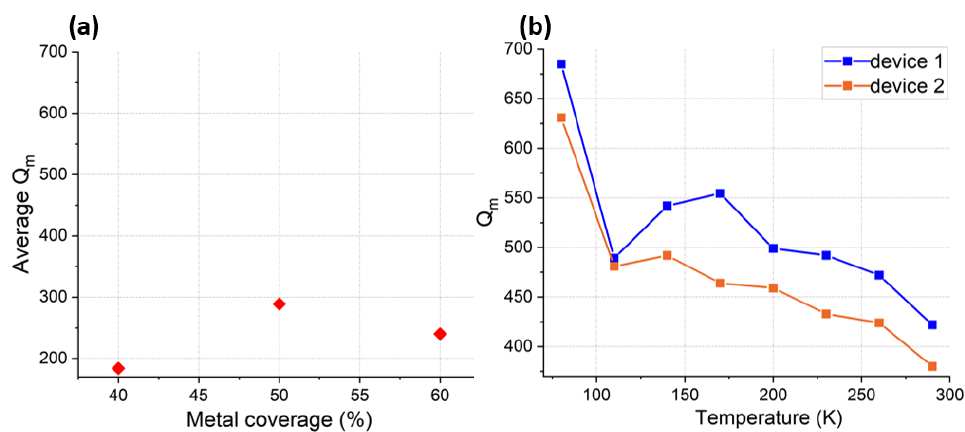
Figure 13. ( a ) Q m of CLMRs with different metal coverage ratios averaged over three identical devices. ( b ) Q m of two identical CLMRs measured from room temperature down to 80 K in steps of 30